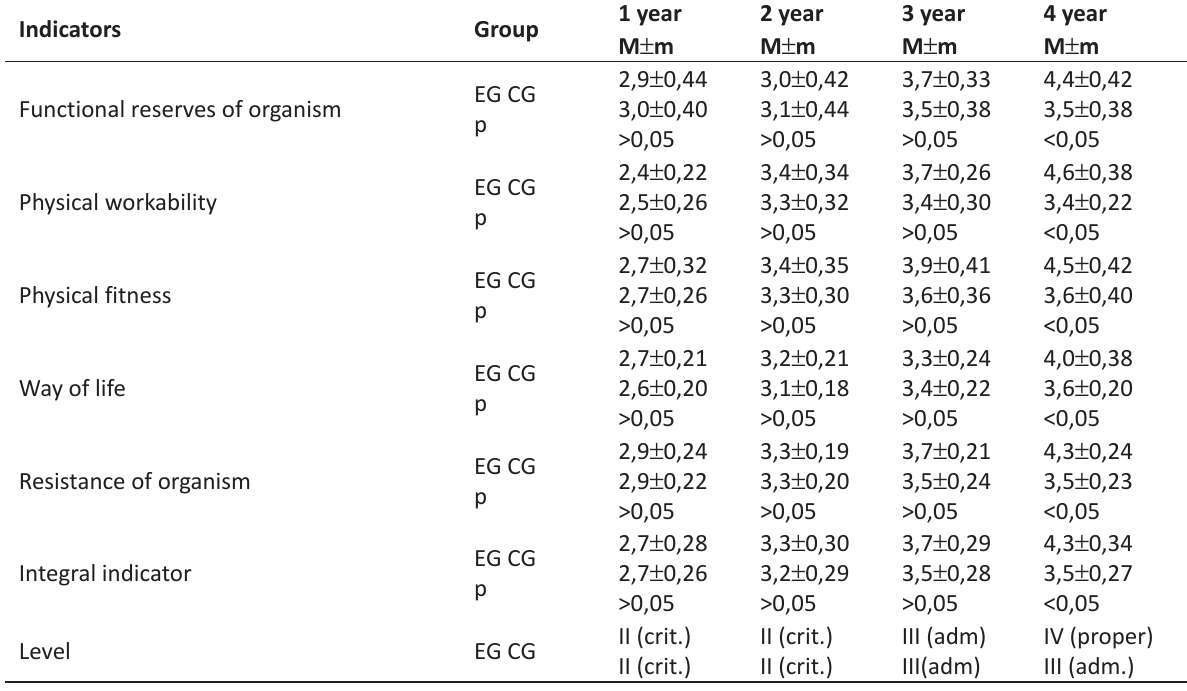
Table 1. Dynamic of changes of students’ individual health in points